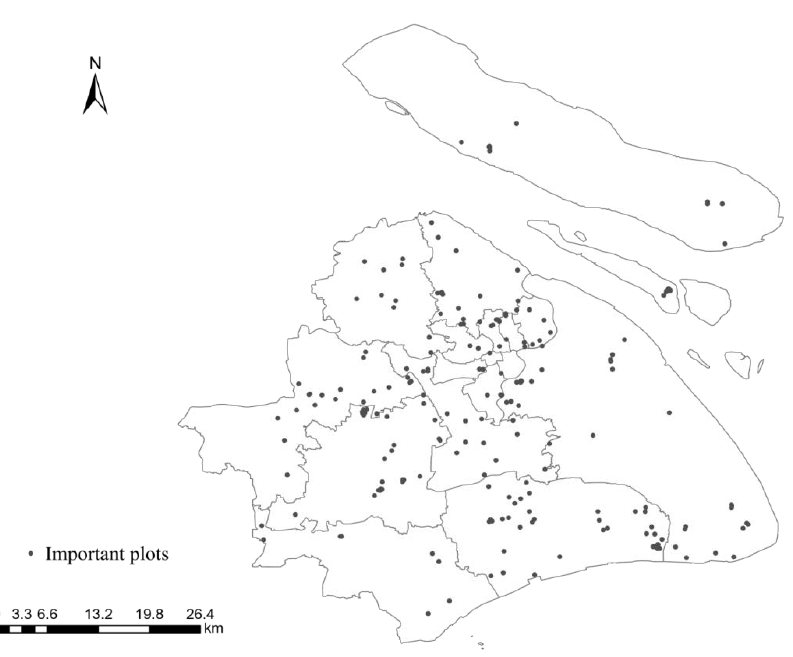
Figure 3. Distribution of important land around rail transit stations in Shanghai.